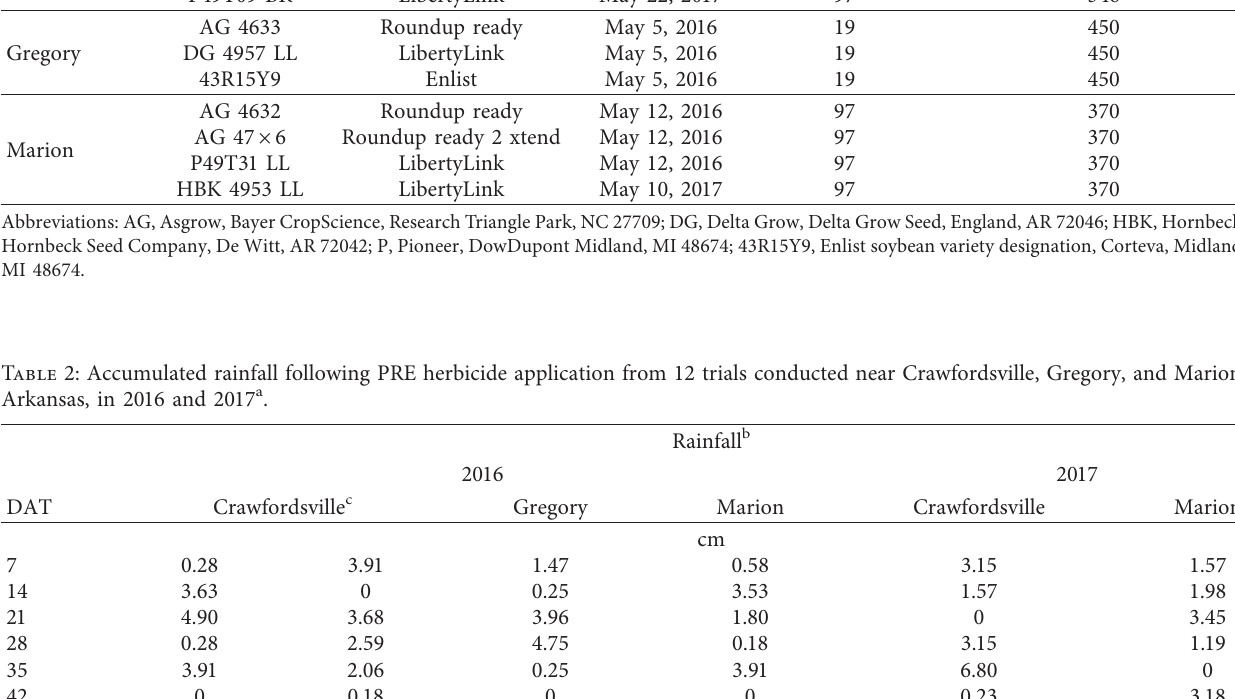
Table 1: Locations, soybean varieties, planting dates, row spacings, and seeding rates for 12 trials conducted in Arkansas, USA, in 2016 and 2017.